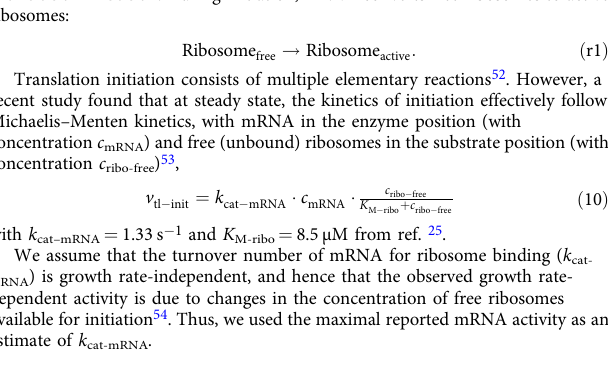
model. We designated the RNA polymerase (molecular weight = 389.11 kD) as the enzyme catalyzing this reaction. For stable RNA (tRNA and rRNA) synthesis, the turnover rate of the RNA polymerase (RNA-P) 1 is k RNAP-sRNA = 85s − 1 . We maximized the fl ux of the RNA synthesis reaction, v sRNA , constrained by the macromolecular budget C = 0.27. The synthesis cost of stable RNA per nucleotide was then calculated as cost nucl-sRNA = 0.27/ v sRNA , expressed as the dry mass Supplementary Table 4. Synthesis cost of mRNA: In E. coli , mRNA transcription is slower than stable RNA transcription. The turnover rate of RNA-P for mRNA is k RNAP-mRNA = 66s − 1 (i.e., the fastest rate of mRNA transcription has been observed to be about three times the maximal translation rate) 51 . As for the calculation of the ATP cost of mRNA, we need to account for mRNA degradation at rate k deg (which is much faster than the degradation of stable RNA). We again assumed that nucleotides from degraded mRNA are re-used by RNA-P to synthesize mRNA. As before, we note that at a given mRNA concentration c mRNA , the production of mRNA must offset the combination of mRNA degradation and mRNA dilution by cellular growth at rate µ . The rate of mRNA production by the RNA-P is thus v mRNA ¼ μ (cid:2) c mRNA þ k deg (cid:2) c mRNA ð 8 Þ To obtain the concentration of RNA-P necessary to catalyze this rate, we need to divide this expression by k RNAP-mRNA : ð 9 Þ Thus, the concentration of RNA-P required for mRNA production is larger by a factor (1 + k deg / μ ) when accounting for mRNA degradation than it would be otherwise. To account for mRNA degradation, we thus set the effective turnover (cid:1) (cid:3) number of RNA-P to k eff (cid:3) mRNA ¼ k RNAP (cid:3) mRNA = 1 þ k deg = μ . We maximized the fl ux of the mRNA synthesis reaction, v mRNA , constrained by the macromolecular budget C = 0.27. The synthesis cost of mRNA per nucleotide was then calculated as cost nucl-mRNA = 0.27/ v mRNA , expressed as the dry mass fraction required to produce 1 mmolg DW − 1 h − 1 of NTP in mRNA. The computed costs for all 20 conditions considered are provided in Supplementary Table 4. Protein content as an alternative cost measure . The protein content was con- sidered as the only relevant cost of the translation machinery in two previous models 9,20 . These models accurately predicted the ribosomal protein fraction in total protein, whereas they substantially underestimated the EF-Tu proteome fraction compared to measurements data 9,20 . Following these earlier works, we calculated the protein cost of a component as the number of amino acid residues it incorporates. Since mRNA and tRNA have zero protein content, this de fi nition assigns no costs to their expression, potentially leading to a prediction of in fi nite concentrations. To avoid such pathological predictions, we set the protein content costs of mRNA and charged tRNAs to small, arbitrary values in the model (mRNA: 10 amino acid residues; tRNA: 5 amino acid residues). Model overview . The mechanistic translation model encompasses the processes of translation initiation, elongation, termination, nucleotide exchange in EF-Tu, and ternary complex (TC) formation. Figure 1 of the main text illustrates the modeled reaction; for better readability, the fi gure shows only a subset of codon/charged